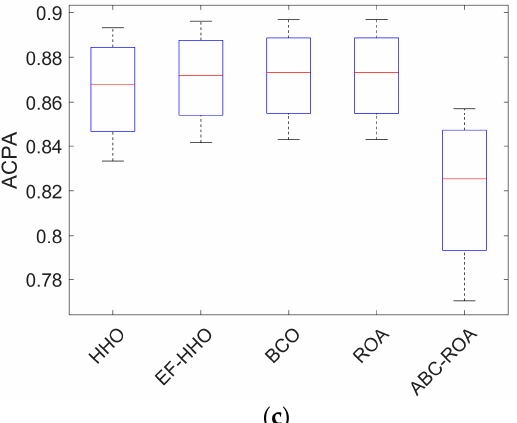
Figure 14. Performance analysis of the developed ABC-ROA based privacy preservation model using ACPA regarding ( a ) dataset 1, ( b ) dataset 2, and ( c ) dataset 3.